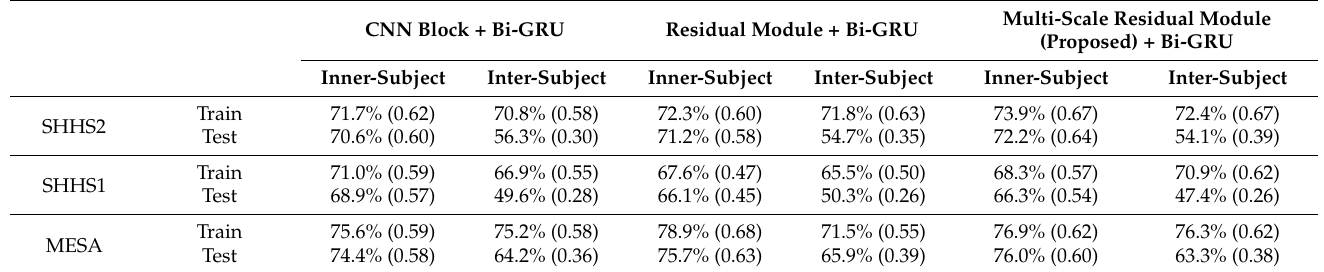
Table 2. The accuracy and Kappa of sleep staging on datasets in inner-subject and inter-subject mode. CNN Block +